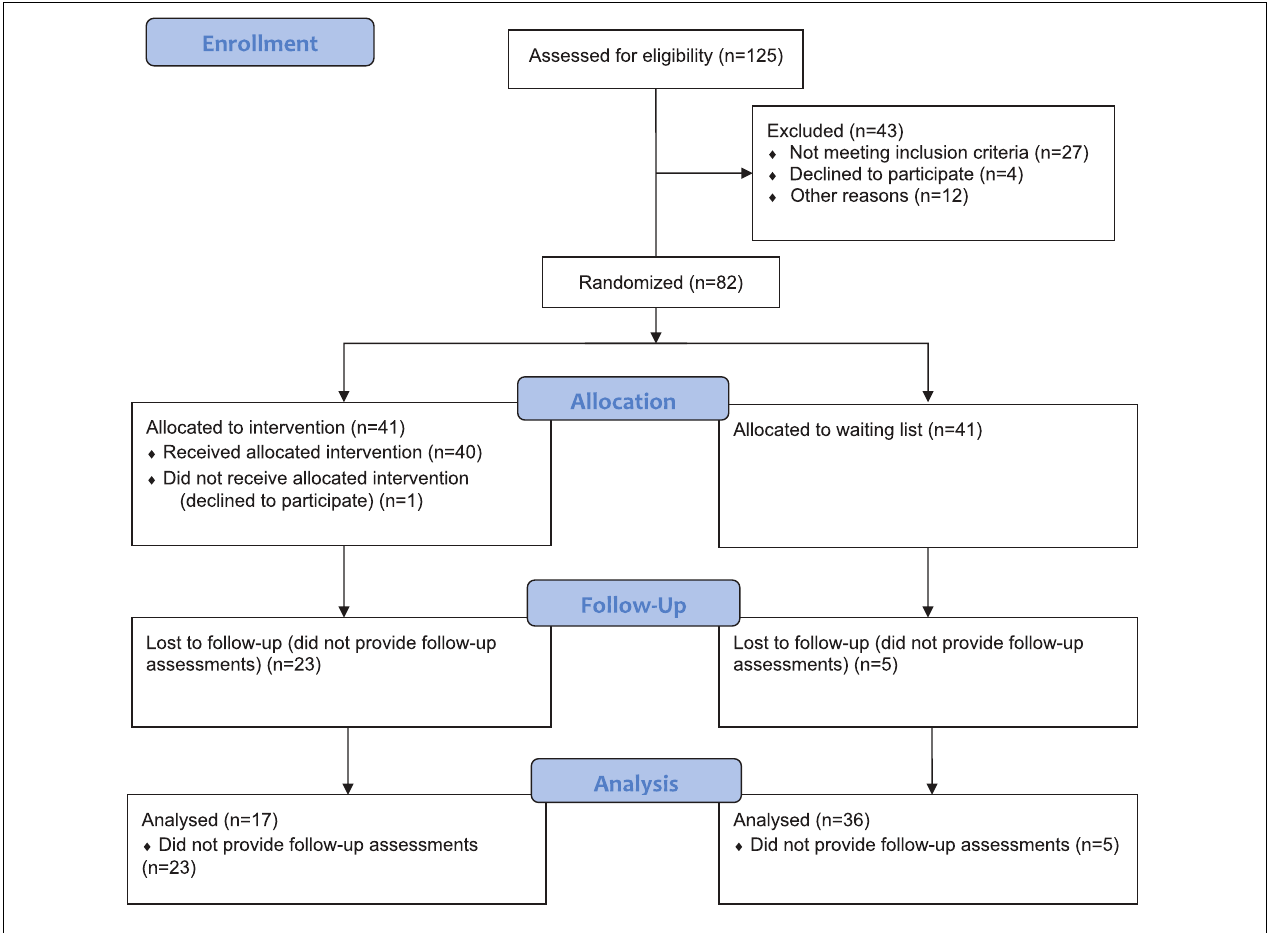
FIGURE 1 | Flowchart of the